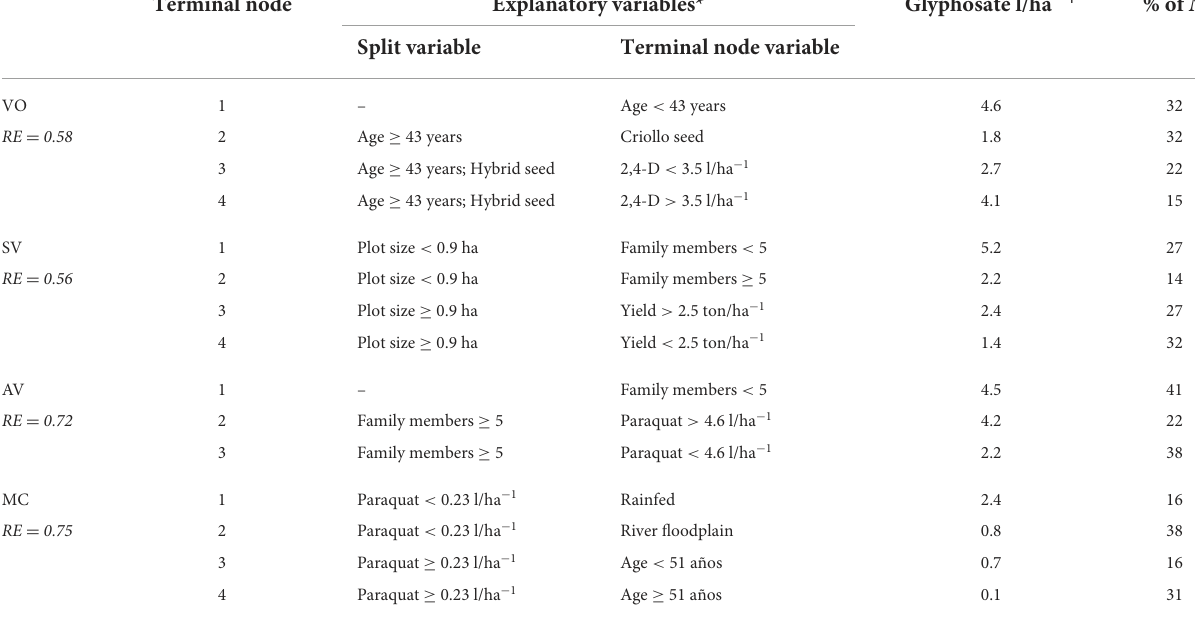
TABLE 4 Summary of the regression trees of each region: number of terminal nodes, the main explanatory variables, average values of the response variable (l/ha − 1 of glyphosate), and the percentage of the regional sample within each terminal node. Terminal